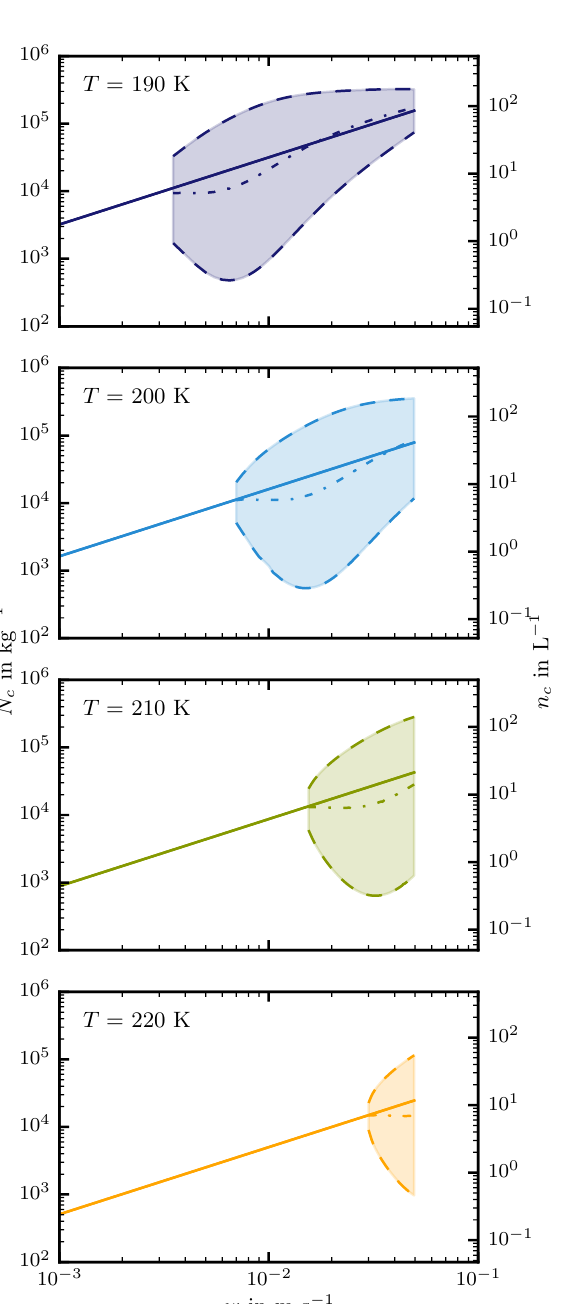
Figure 9. Ice crystal number concentrations for different temper- ature scenarios ( T = 190 , 200 , 210 , 220K). The solid line repre- sents values at the equilibrium state x 0 (stable or unstable focus). For the limit cycle regime the range of ice crystal number concen- trations is indicated by the shaded area bounded by minimum and maximum values for the updraught range 0 . 001 ≤ w ≤ 0 . 05ms − 1 ; the median is indicated by the dot-dashed line.